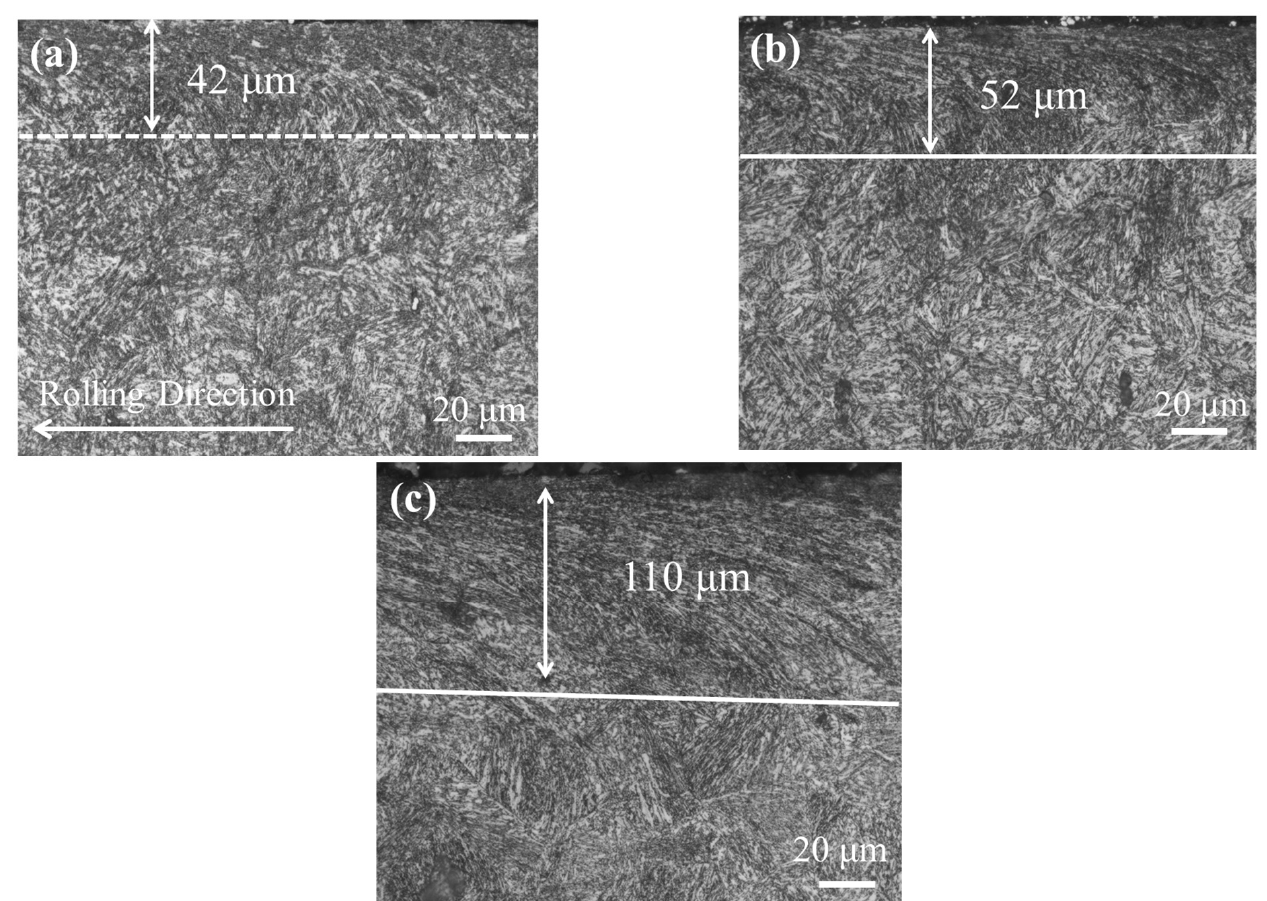
Figure 6. OM images of the gradient strain layer of the wheel specimens: ( a ) 80 km/h, ( b ) 120 km/h and ( c ) 150 km/h.